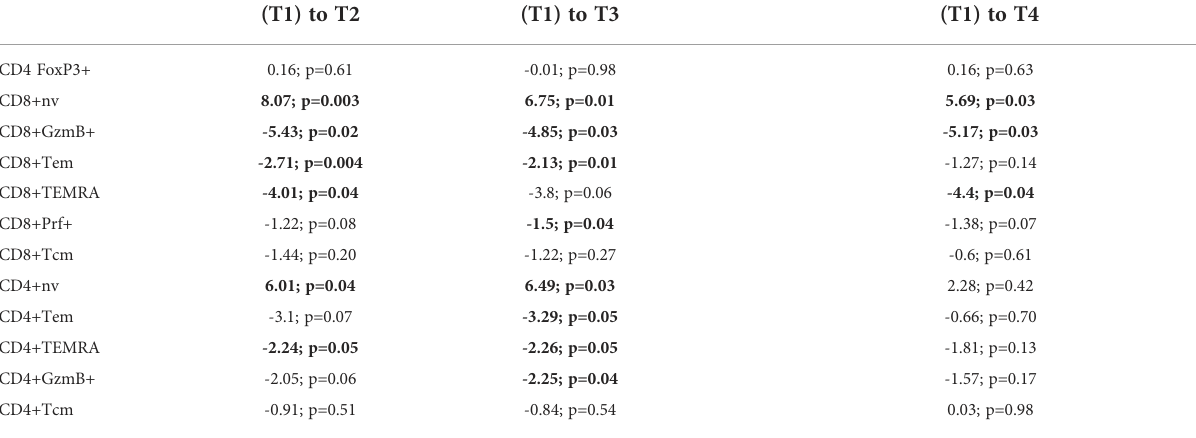
TABLE 3 Estimated change from baseline to each follow-up time point in patients in the 50 m g